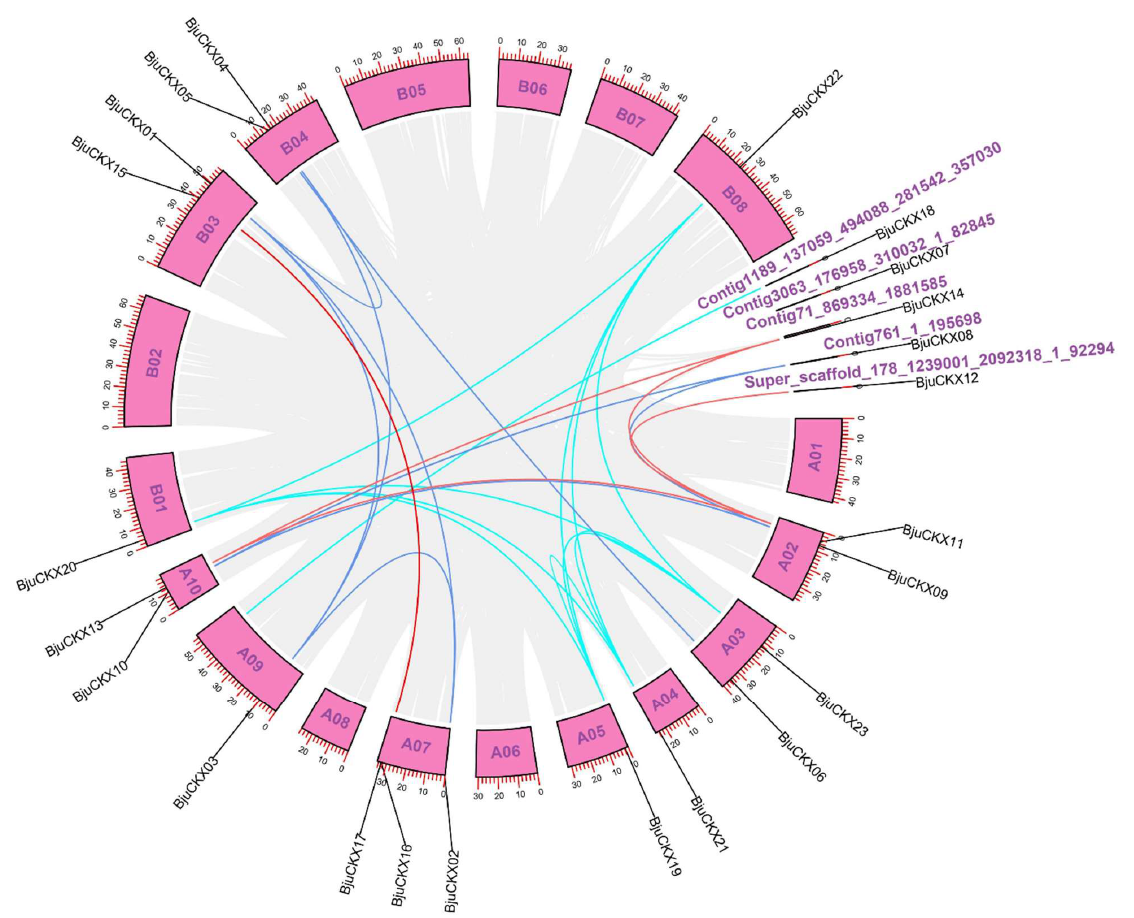
Figure 2. Collinearity analysis of CKX gene family in B. juncea . Eighteen chromosomes, four contigs, and one scaffold are arranged into a single-colored circle. The colored line connecting the chromo- somes represents the different collinear region of BjuCKX genes. Blue, pink, red, cyan line represents the I, IV, V, VI subgroups, respectively.